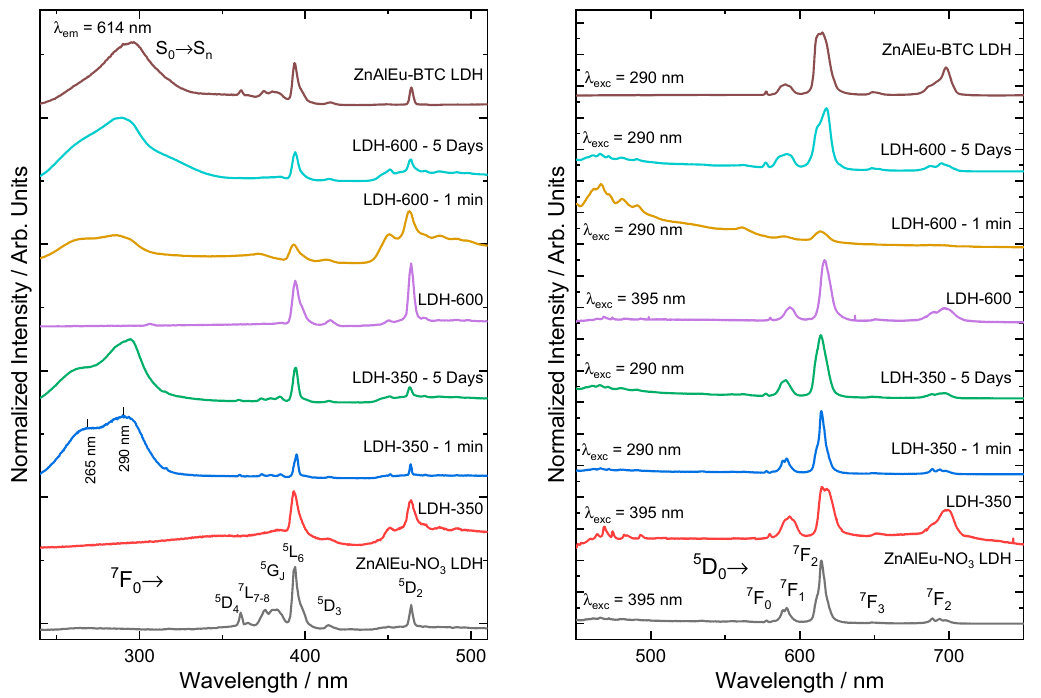
Figure 6. ( left ) Normalized excitation spectra recorded at 300 K, monitoring the (Eu 3+ ) 5 D 0 → 7 F 2 emission at 614 nm of the ZnAlEu–NO 3 LDH (as-prepared) together with the calcined and rehydrated samples. ( right ) Normalized emission spectra (300 K) under excitation at the BTC ligand-to-metal transference band (290 nm) for the rehydrated samples and under excitation at the (Eu 3+ ) 7 F 0 → 5 L 6 excitation band at 395 nm for the as-prepared and calcined samples. The labels of the 4f-4f intraconfigurational transitions of Eu 3+ are shown. The spectra of the sample ZnAlEu–BTC LDH are shown for comparison.